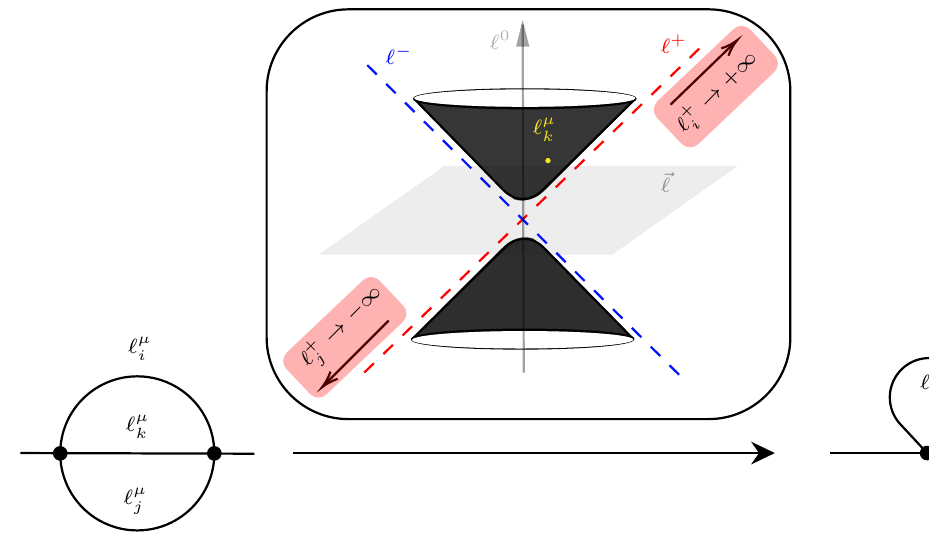
Figure 4 . Special configurations of the sunrise graph through loop momenta going to infinity along opposite directions on the light-cone (either or ). The ambiguity in choosing the direction ` ´ ( or ) is transparent at the diagrammatic level since ‘ ` , ‘ ` , ‘ ´ , ‘ ´ , j j q Ñ p´8 j j q Ñ p´8 p `8q p `8q the sunrise graph contracts to the same one-loop tadpole. By momentum conservation, ‘ µ ` ˘ 3 a finite point on the momentum shell. There are 3 distinct pairs of i, j . The result of two 2 “ virtual particles propagating infinitely fast in a sunrise diagram (left most Feynman diagram) is a one-loop tadpole (right most Feynman